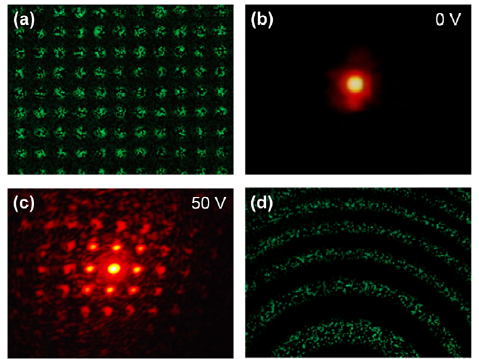
Figure 10. ( a ) Reflection micrograph; ( b , c ) far field diffraction patterns of a 2D BP-ISO array obtained by erasing the previous 1D grating and repatterning the sample into a 2D grating; ( d ) reflection micrograph of the same blue phase templated azo-LC cell repatterned into a Fresnel zone plate. Reproduced from Ref. [89]. Optical Society of America, 2019.